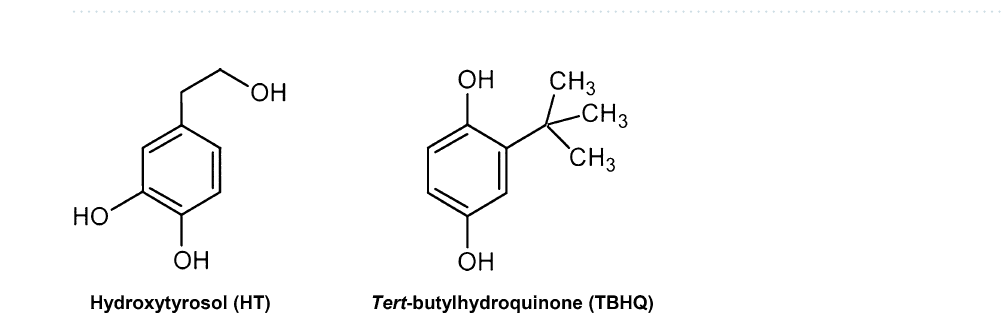
Figure 2. Molecular structure of hydroxytyrosol and tert